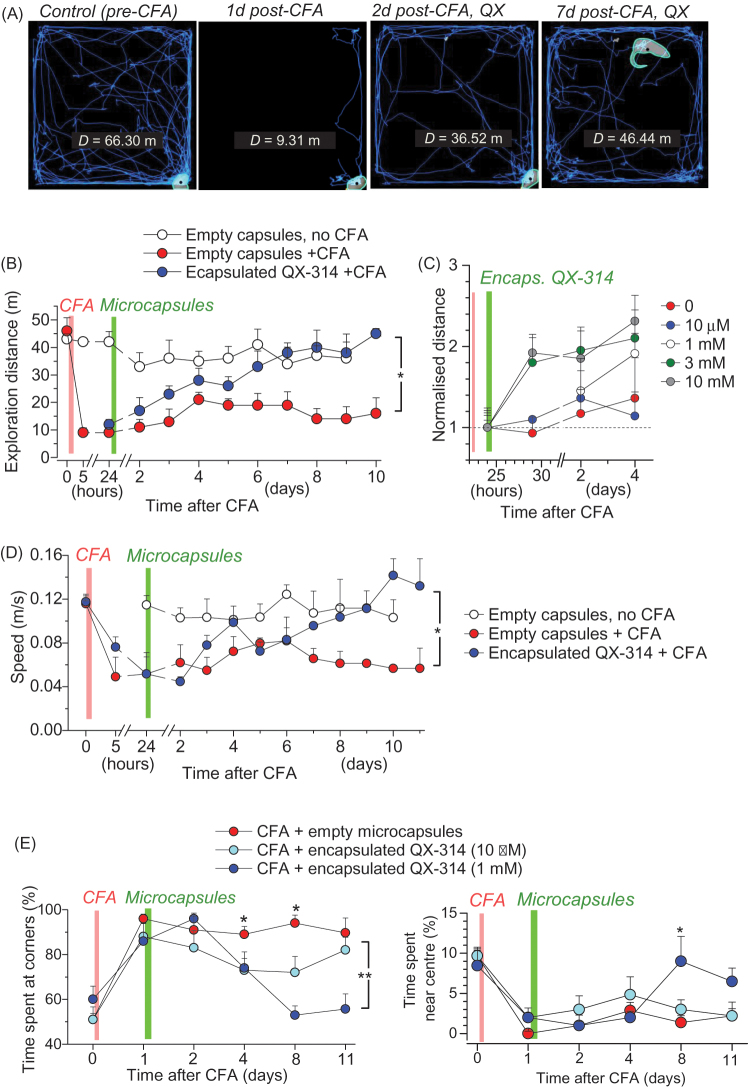
Encapsulated QX-314 abolishes locomotive deficit and anxiety in animals with persistent peripheral inflammation. (A) Examples of the open-field test trajectory records taken from one animal at different time-points following CFA injection and treatment with encapsulated QX-314 (1 mM, 1 day post-CFA), as indicated; D, overall distance (m) traveled over 10.0 min. (B) The effect of encapsulated QX-314 on animal locomotion: time course of the average exploration distance traveled by CFA-inflamed animals injected with encapsulated QX-314 (1 mM) or empty microcapsules, and by healthy animals (no CFA) injected with empty microcapsules. (C) The dose-effect of encapsulated QX-314 on exploratory activity in CFA-inflamed animals: time course of the average distance (normalized by that 1 day post-CFA) traveled by CFA-inflamed rats; treatment with empty capsules (n = 5 rats), 10 µM encapsulated QX-314 (n = 5), 1 mM encapsulated QX-314 (n = 5), 3 mM encapsulated QX-314 (n = 9), 10 mM encapsulated QX-314 (n = 6), as indicated. (D) The effect of encapsulated QX-314 on the average speed that animals could develop following treatment; notations as in (B). (E) The effect of encapsulated QX-314 on the animal’s anxiety, estimated as the average fraction (%) of time spent in the arena corners (correlative anxiety indicator; left) versus the arena center (anti-correlative anxiety indicator; right). Treatment with empty capsules (n = 5 rats), 10 µM encapsulated QX-314 (n = 5), 1 mM encapsulated QX-314 (n = 5). Data are shown as mean ± SEM. *p < .05, **p < .01 (one-way ANOVA with Bonferroni post hoc test).